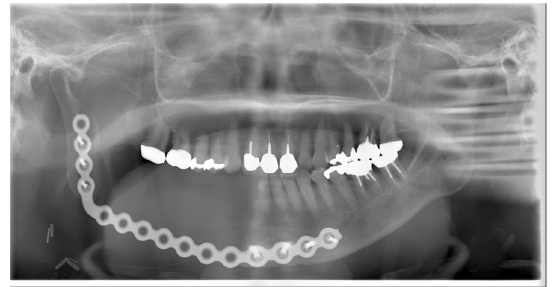
Fig. 7 Panoramic radiographs on postoperative day 8. The image findings confirmed that the plate was intact